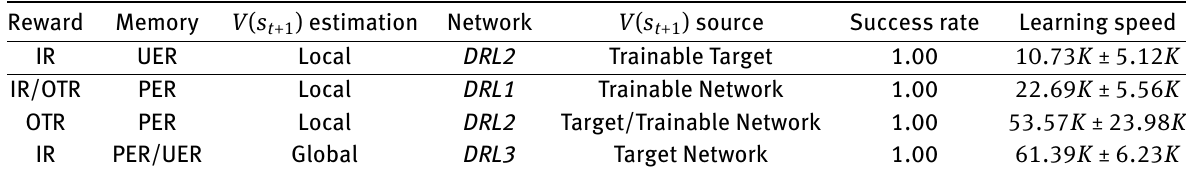
Table 4: The first row of the table presents the fastest RL agent with 100% success rate. The next three rows show the largest combinations of factors (which is 2) that can create an agent with a 100% success rate.